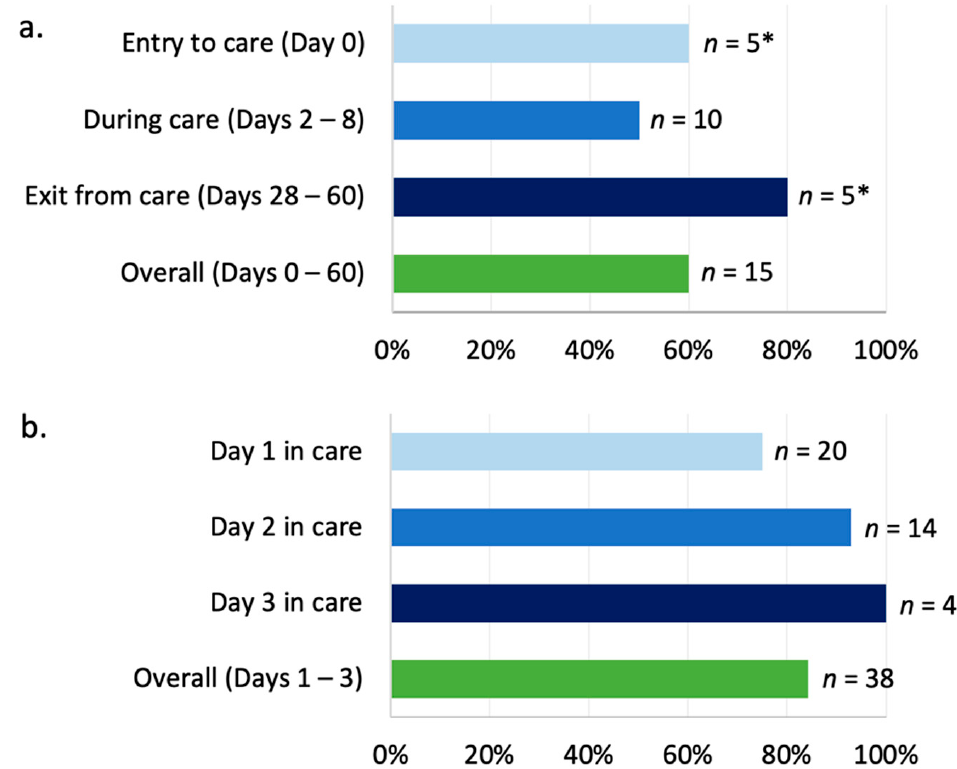
Figure 1. Prevalence of amoxicillin-resistant Escherichia coli in detected in faecal samples from orphaned, abandoned, and heat-stress-affected grey-headed flying-fox (GHFF) pups entering care in South Australia during the 2018/2019 pup season. The y -axis indicates when pups were sampled relative to entering care. The number ( n ) of pup faecal samples tested is listed adjacent bars. ( a ) Pups housed alone or in small groups; prevalence of amoxicillin-resistant E. coli in GHFF pups at entry to care, during care, and at exit from care. Asterisks (*) indicate that the same five pups were sampled both at entry to care and at exit from care. ( b ) Pups co-housed in one large group; prevalence of amoxicillin-resistant E. coli in GHFF pups 1–3 days after entering